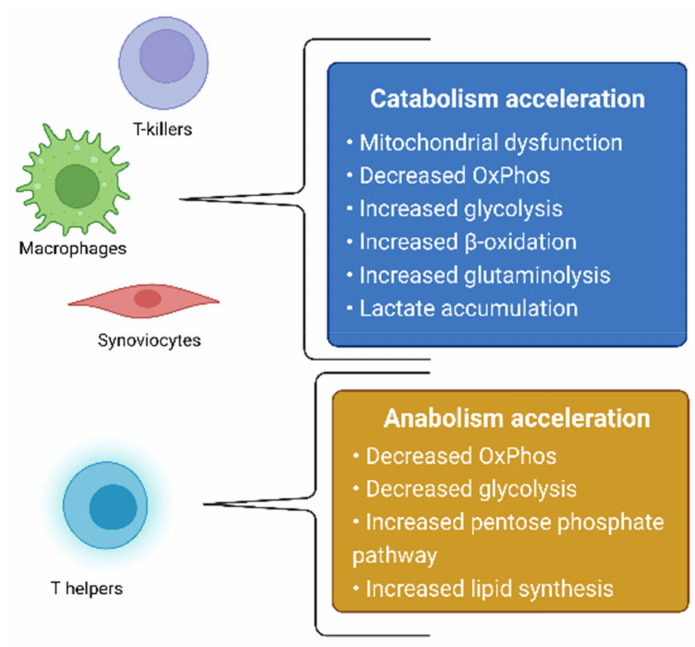
Figure 1. Summarized metabolic changes for cells involved in the pathogenesis of